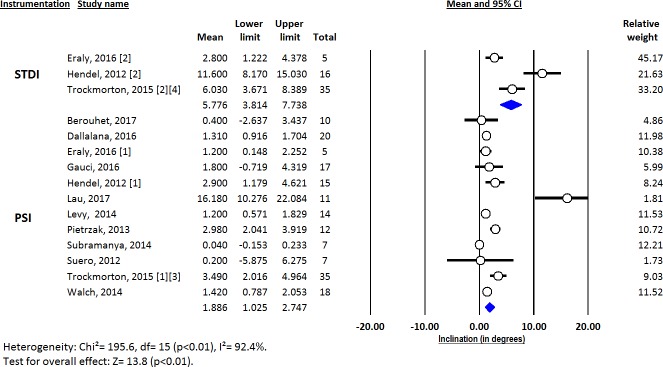
Forest plot of inclination deviation from the pre-operative planning, for all included studies.